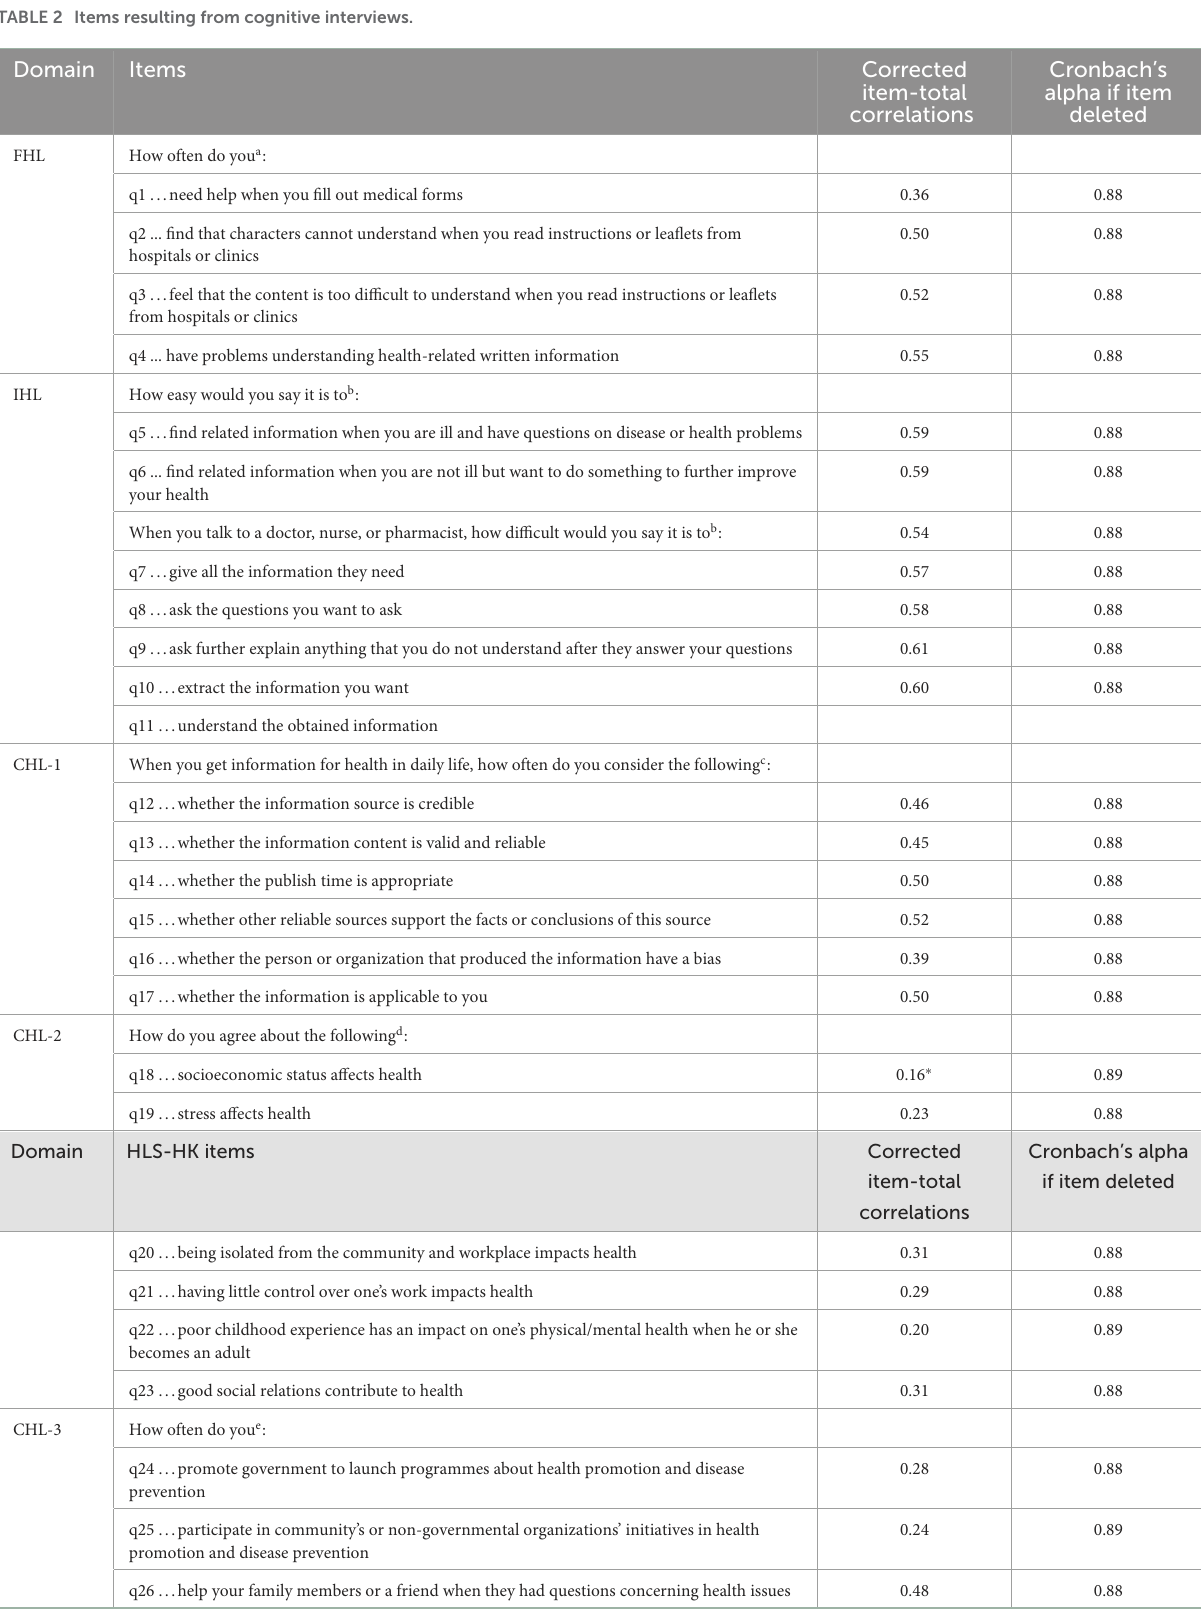
TABLE 2 Items resulting from cognitive